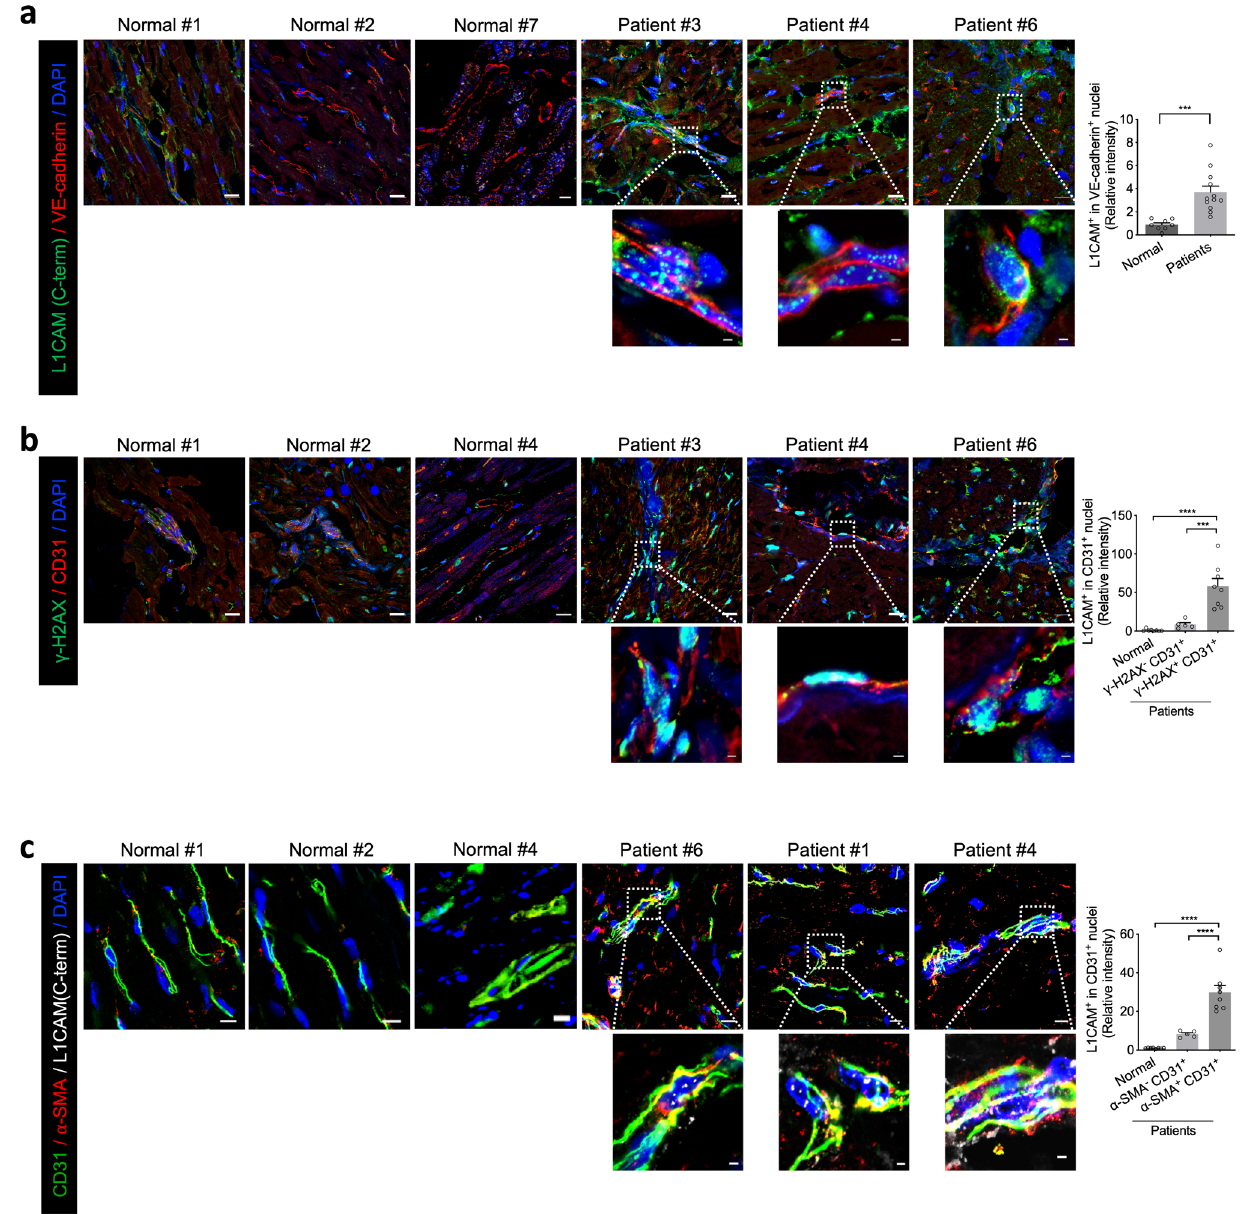
Fig. 6 Nuclear L1CAM localisation with vascular EndMT and γ -H2AX L1CAM colocalization in heart tissues from patients with cardiomyopathy. a Immuno fl uorescence staining of L1CAM and VE-cadherin in heart tissues from patients with cardiomyopathy ( n = 12) and patients without cardiomyopathy ( n = 8) (magni fi cation, ×400). Scale bar = 10 μ m (enlarged, 2 μ m). Error bars represent mean ± SEM ( p = 0.0004). b Immuno fl uorescence staining of γ -H2AX and CD31 in heart tissues from patients with cardiomyopathy and patients without cardiomyopathy (upper panels) and quanti fi cation (lower panel) of nuclear L1CAM + cells among CD31 + cells (magni fi cation, ×400). Scale bar = 10 μ m (enlarged, 2 μ m). Error bars represent mean ± SEM (Normal vs. γ -H2AX + CD31 + p > 0.0001; γ -H2AX ‒ CD31 + vs. γ -H2AX + CD31 + p = 0.0003) c Immuno fl uorescence staining of L1CAM, α -SMA, and CD31 in heart tissues from patients with cardiomyopathy and from patients without cardiomyopathy (upper panels) and quanti fi cation (lower panel) of nuclear L1CAM + cells among α -SMA - CD31 + and α -SMA + CD31 + cells (magni fi cation, ×400). Scale bar = 10 μ m (enlarged, 2 μ m). Error bars represent mean ± SEM ( p > 0.0001). ( a two-tailed student ’ s t -test; b , c one-way ANOVA for multiple